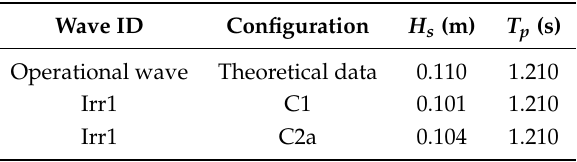
Table 9. Irregular wave records spectral properties.